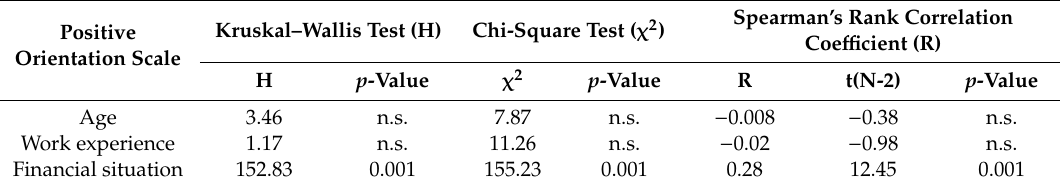
Table 1. Significance of impact: age, work experience, and financial situation on the level of positive